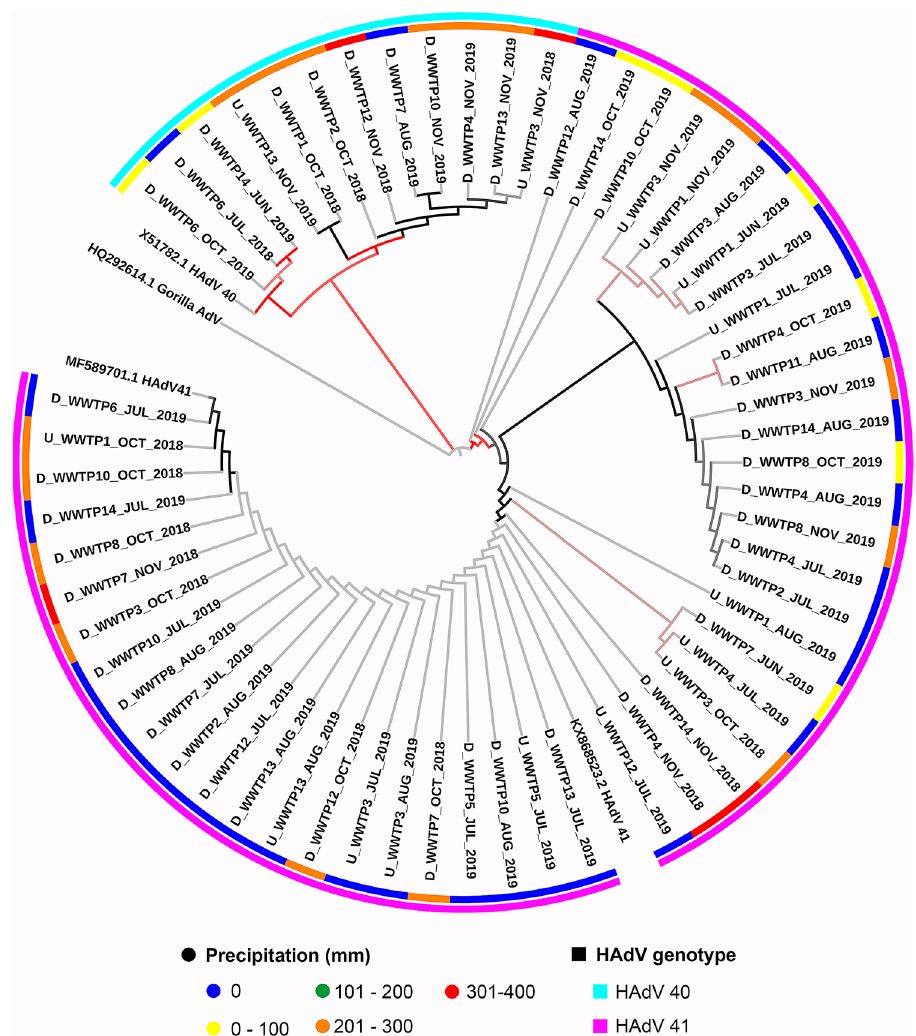
Fig. 2 Phylogenetic analysis based on the nucleotide sequence of the hexon gene for HAdV positive samples. The bootstrap values are repre- sented by the colors red (100) and black (minimum